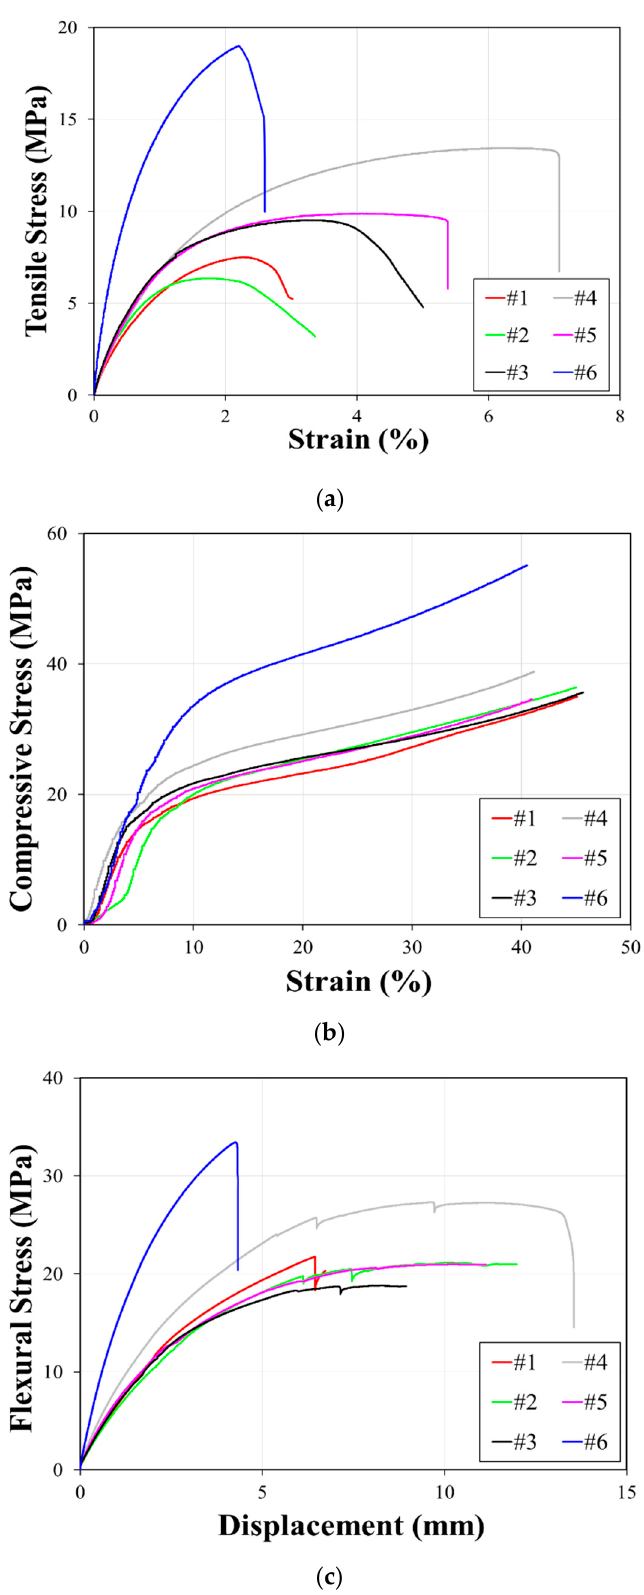
Figure 7. Mechanical responses of particulate composites: ( a ) tensile stress–strain relationships, ( b ) compressive stress–strain relationships and ( c ) flexural stress–displacement relationships.